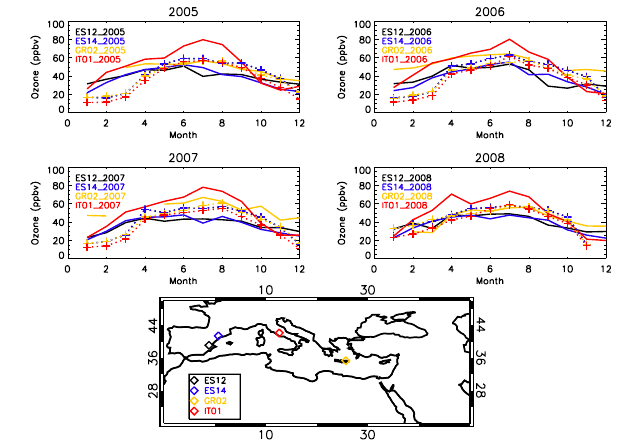
Fig. 1. Comparison of TOMCAT (dotted lines/symbols) and EMEP (solid lines) monthly mean surface ozone (ppbv) for the years 2005– 2008. The different colours represent the different stations as de- picted on the map in the lower panel, where ES12 = Zarra, ES14 = Els Torms, GRO2 = Finokalia and IT01 =